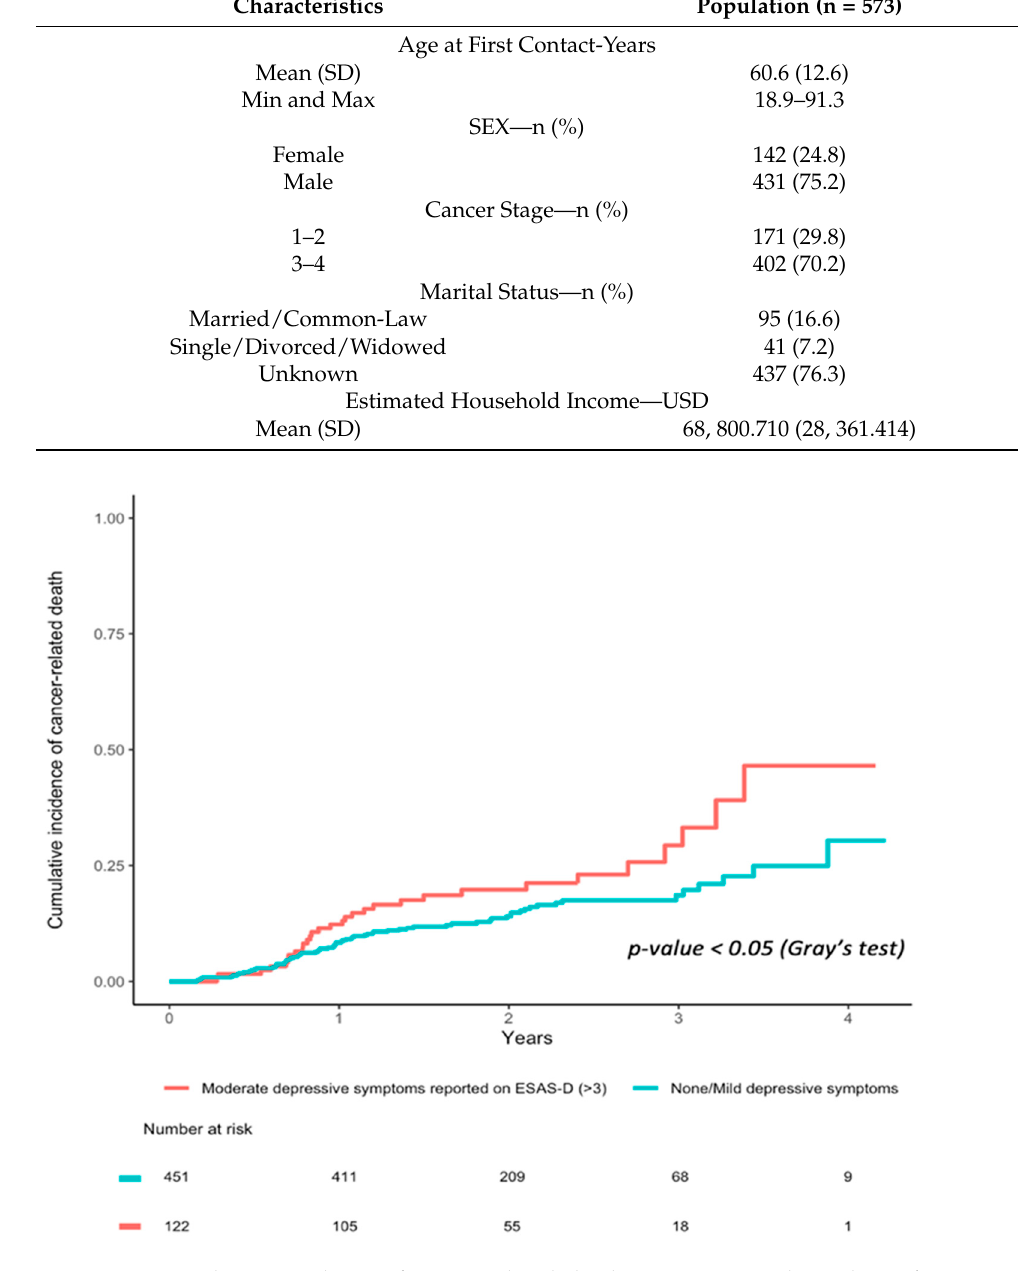
Figure 1. Cumulative incidence of cancer-related death in patients with moderate/severe vs. none/mild ESAS depressive symptoms reported at diagnosis. Table 4. Hazard ratios for cancer-related deaths in patients with moderate/severe vs. none/mild on the ESAS depression item at